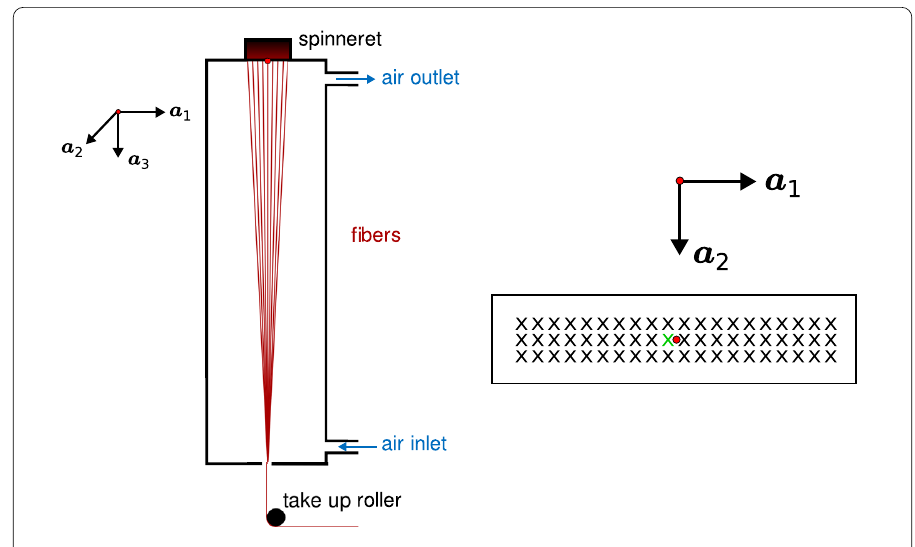
Figure 1 Industrial dry spinning setup for uni-axial fibers with take up of the produced fibers at the bottom side of the spinning duct. Left: Sketch of the dry spinning device and orientation of the outer basis { a 1 , a 2 , a 3 } . Right: Sketch of the holes (markedwith X ) in the spinneret (not in scale). All proceeding simulation results are shown for the fiber extruded from the central position (green X